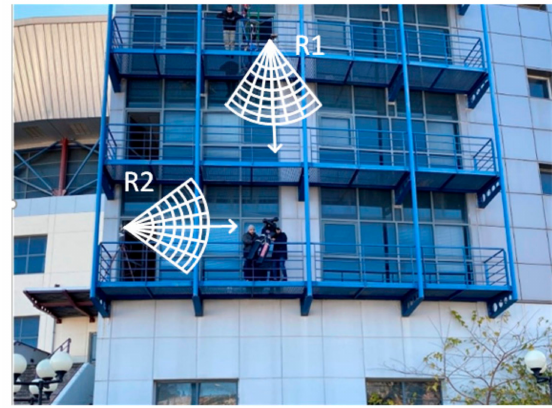
Figure 2. System